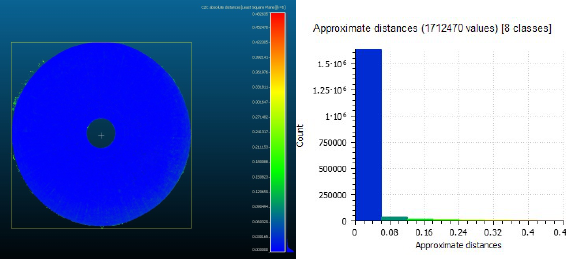
Figure 11: Discrepancy (m) map and histogram between the TLS point cloud and EOS3 – Medium processing.